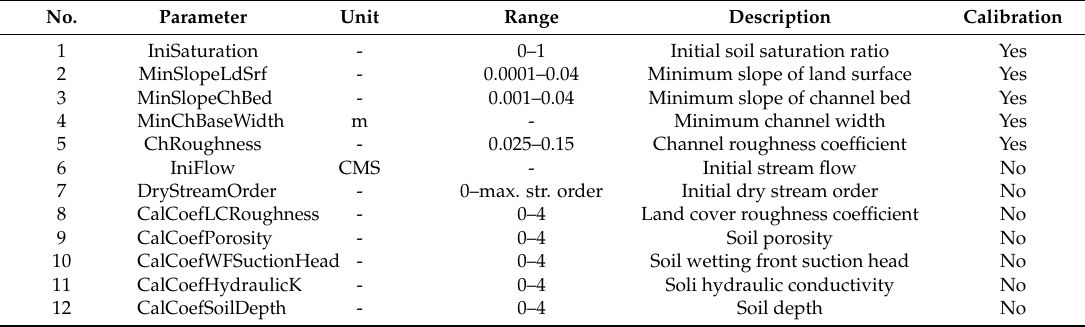
Table A2. Description of the GRM model parameters.